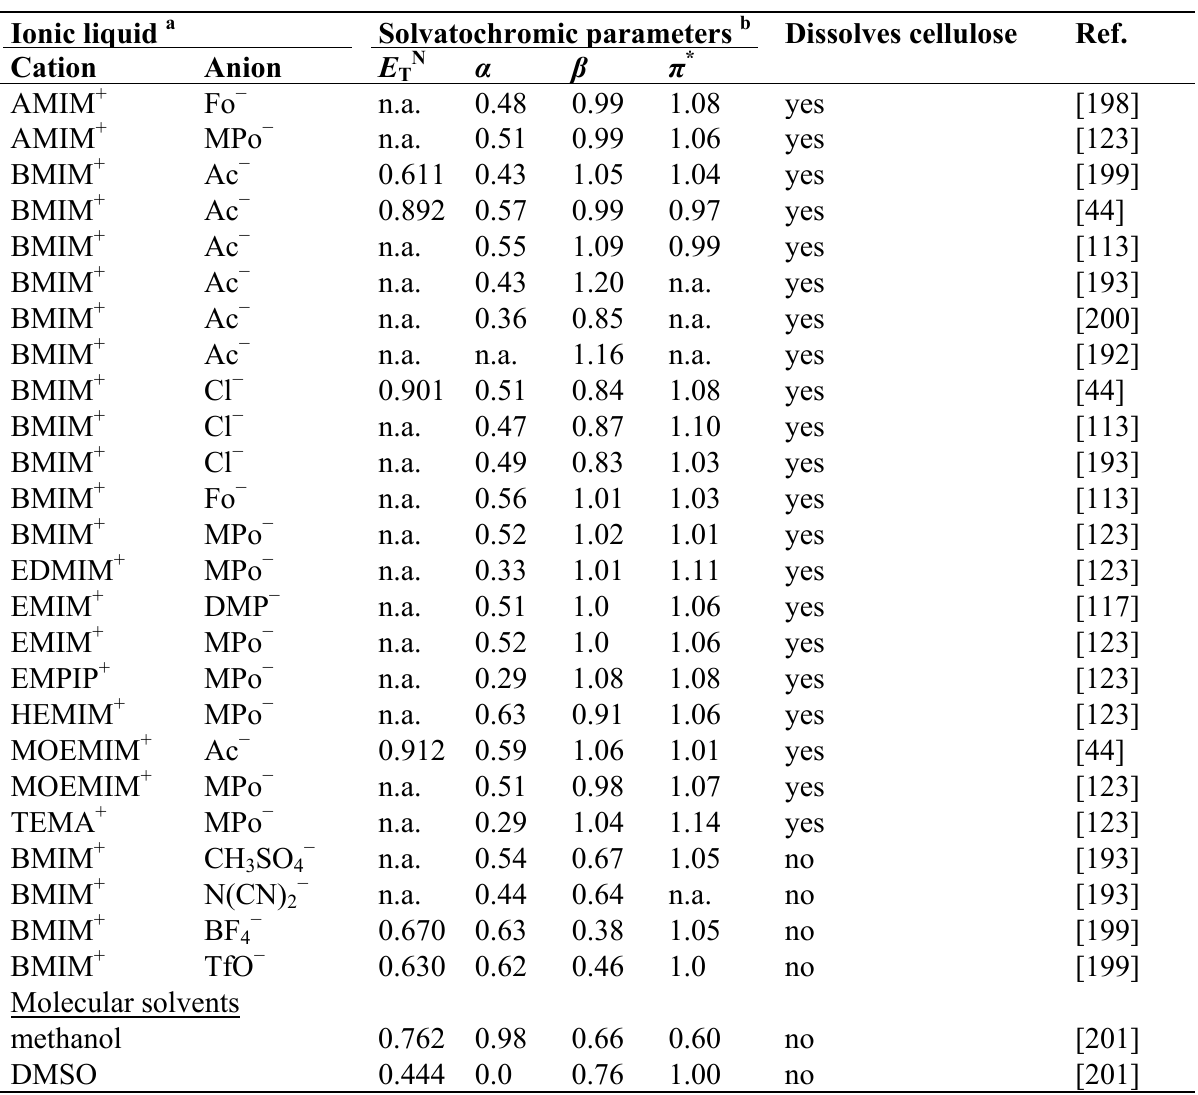
Table 4. Solvatochromic parameters of ionic liquids that are or are not able to dissolve cellulose. Ionic liquid a Solvatochromic parameters